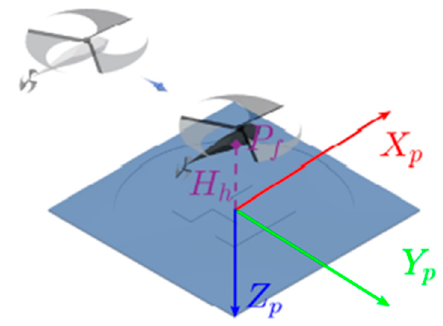
Figure 33. Diagram of following stage.